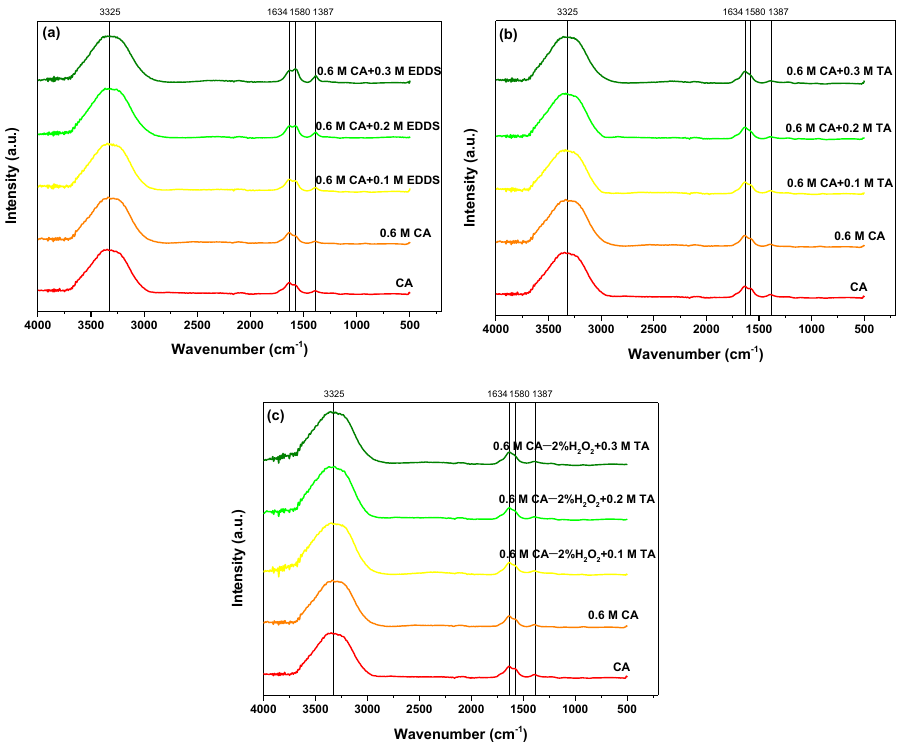
Figure 6. FTIR spectra of PLS solutions obtained using ( a ) 0.6 M CA with EDDS, ( b ) 0.6 M CA with TA, and ( c ) 0.6 M CA with TA with the additional amount of H 2 O 2 .